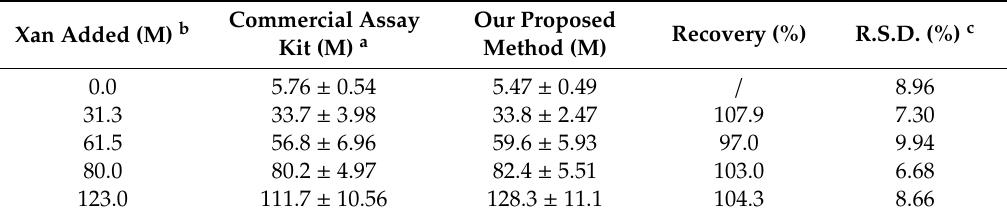
Table 2. Determination of Xan levels in human plasma.